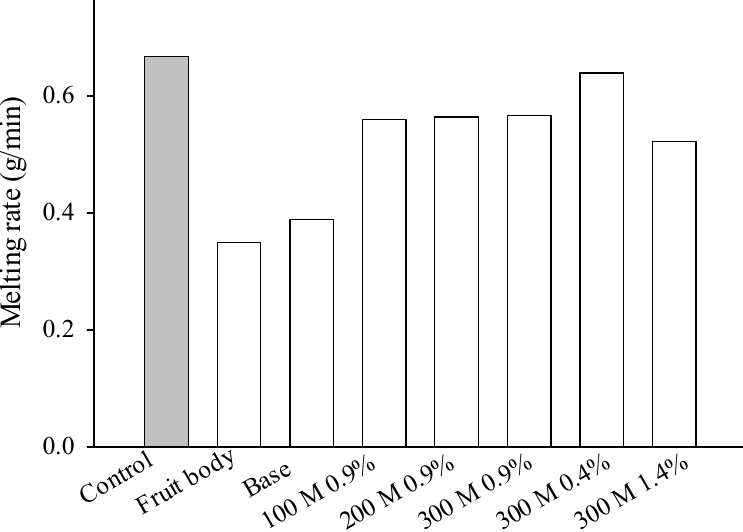
Figure 4. Melting rate of T. fuciformis ice creams.